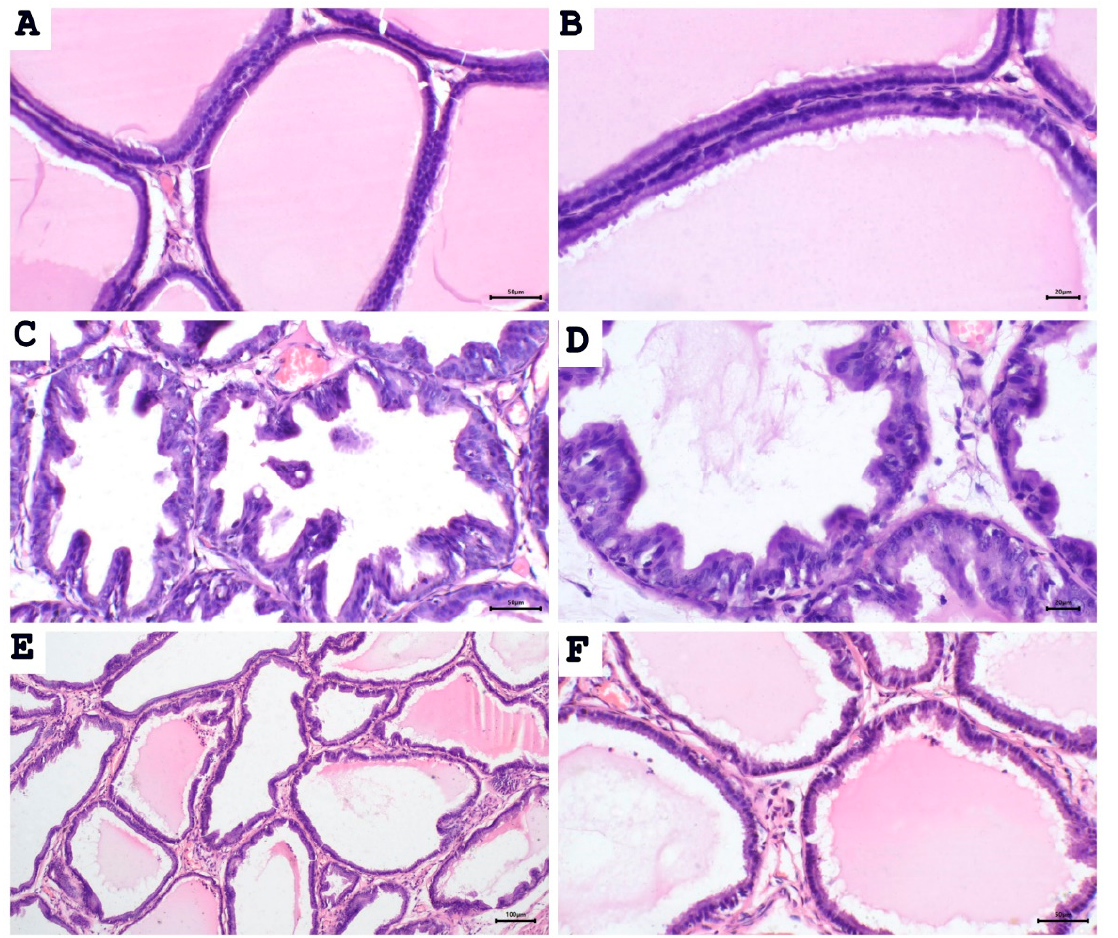
Figure 2. Aescin abrogates the testosterone-induced proliferation in the prostate. Sections of rat prostate stained with hematoxylin–eosin from the control, BPH, and BPH rats treated with aescin (10mg/kg, p.o.) for 4 weeks are shown. ( A ), ( B ): Prostatic sections from the control group show the normal histoarchitecture of the prostate gland with regular size acini. The acini contain prostatic secretions in the lumen. The acini are lined with simple columnar epithelium (( A ), 200×). Fine stroma and a continuous basal layer are also noted (( B ), 400×) (control group). ( C ), ( D ): Prostate sections from the untreated BPH animals show irregular acinar shape with papillary projection into the lu- men, and foci of piling-up hyperplastic nodules are evident. (( C ), 200× and ( D ), 400×). The epithe- lium is highly cylindrical, multilayered, and shows irregularly aligned round/ovoid nuclei. ( E ), ( F ) : Prostate sections from BPH animals treated with aescin show marked reduction in hyperplasia and hypertrophy (( E ), 100× and ( F ), 200×).